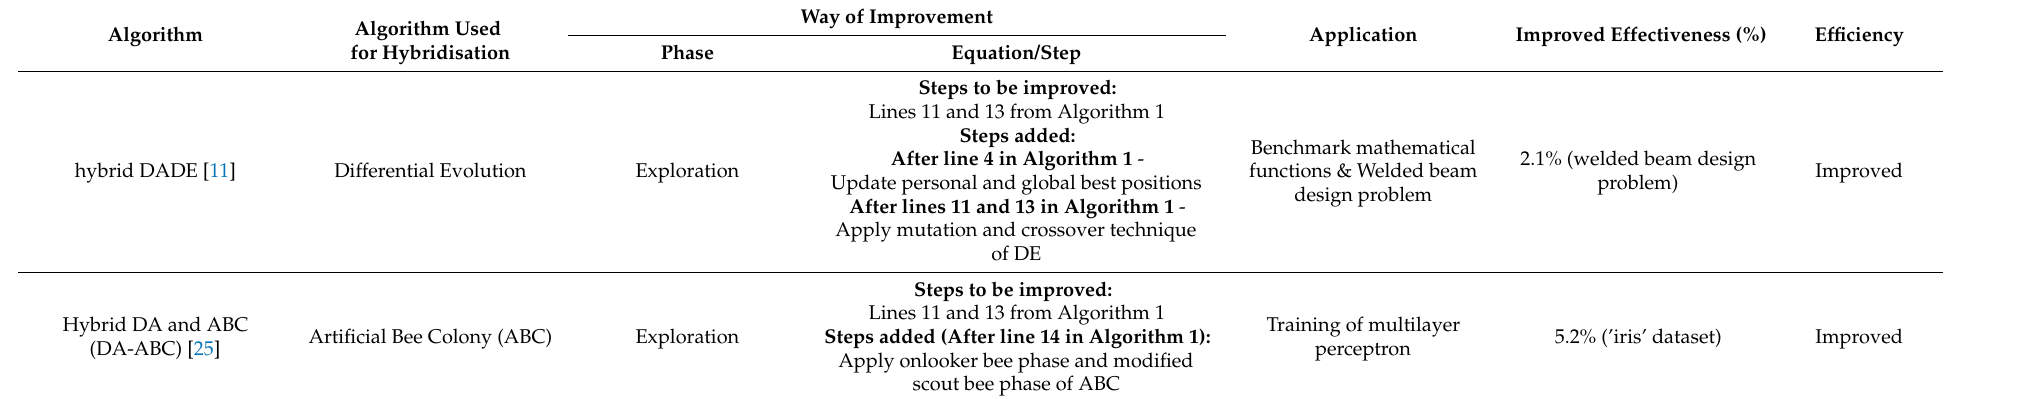
Table 3. Hybrids of DA which improve its effectiveness by improving